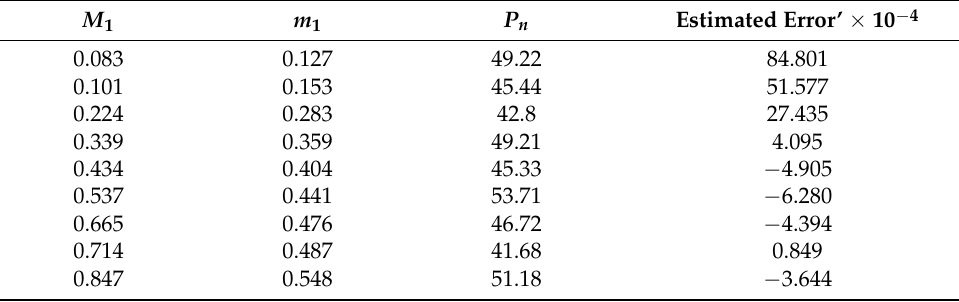
Table 9. The input data for high conversion and r 1 = 0.02 and r 2 = 0.40